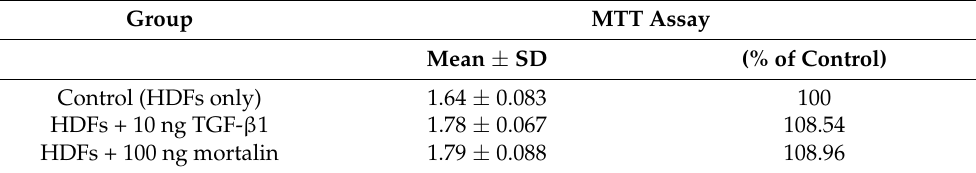
Table 1. Cell proliferation activity of mortalin using MTT assay.